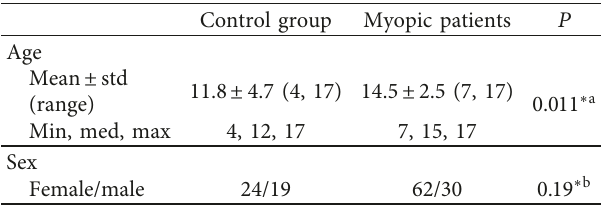
Table 1: Characteristics of control and myopic patients